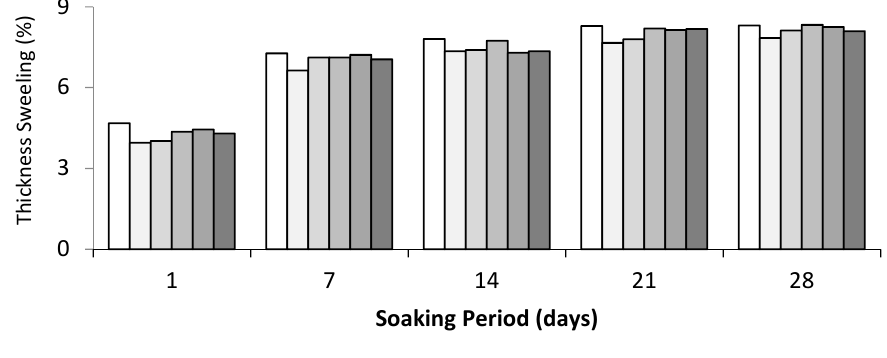
Figure 7. Thickness swelling of jute–ramie hybrid